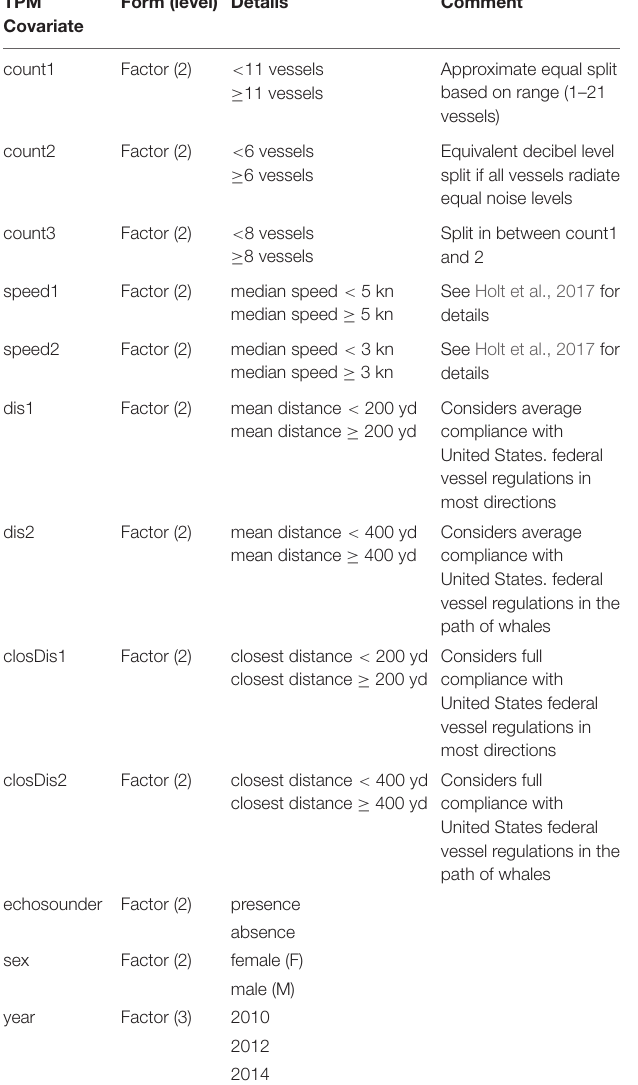
TABLE 2 | Definitions of single covariates on the state transition probability matrix of candidate models. TPM Covariate